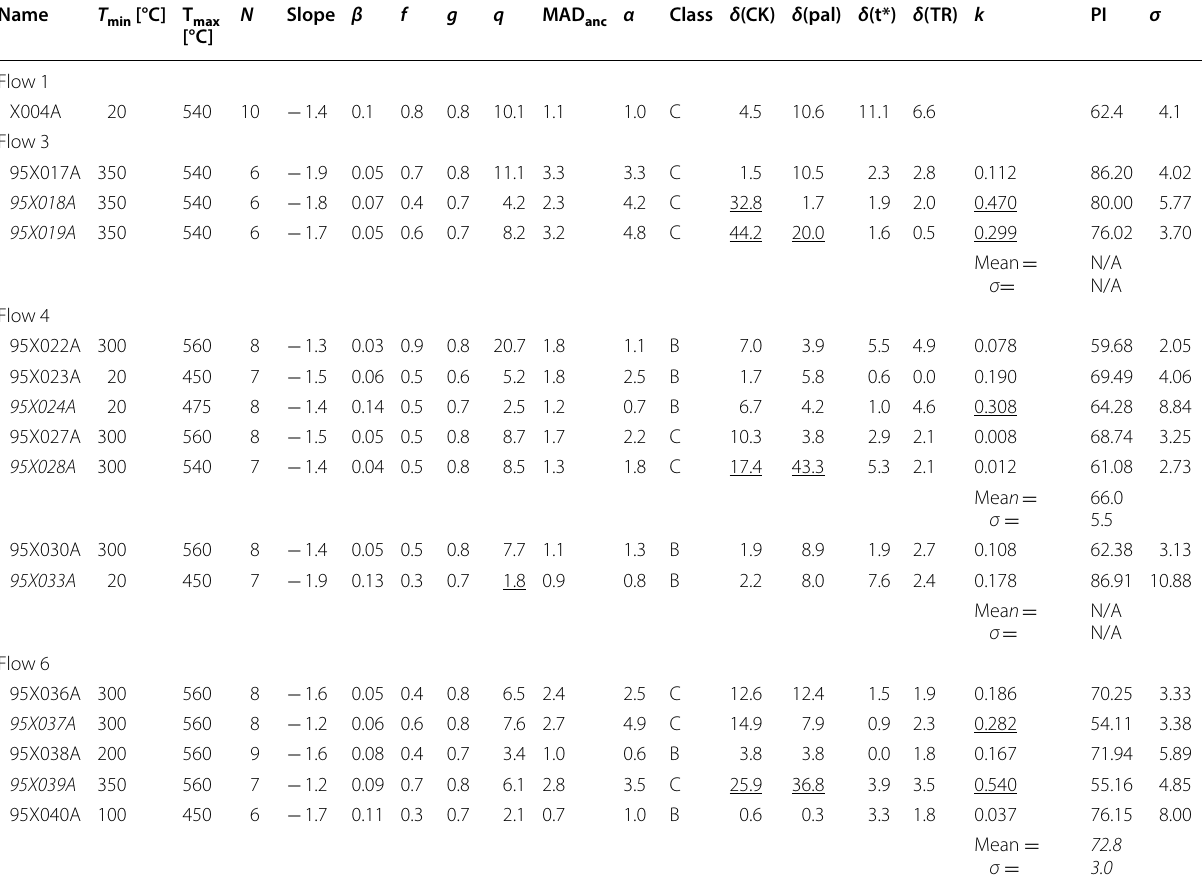
Terms from column 4 (“ N ”) to column 16 (“ δ (TR)”) as defined in Table 1. k : curvature. k R − 1 , where R is the radius of the fitted circle to the data set (pTRM vs NRM); PI: = paleointensity; σ : standard deviation of paleointensity. Specimen names in italic face correspond to specimens rejected for the average intensity calculation because of exceeding of at least one of the threshold values (underlined) set for the corresponding assigned